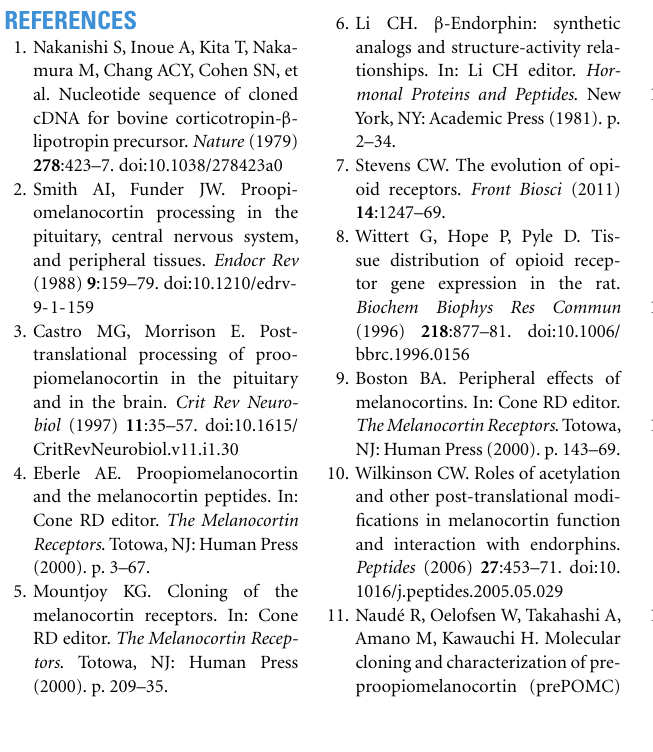
the production of MSH and the opioid peptides β -END and Met- ENK. This functional differentiation may have been established in the evolutionary antecedent of lampreys. α -MSH and β -END are frequently acetylated, and the presence or absence of an acetyl group modifies the biological activities in many vertebrate classes. The lack of acetylated peptides in the PI of lamprey and cartilagi- nous fish pituitaries suggests that acetylation is not a commonly occurring modification in vertebrates. However, the presence of an acetylation system in tetrapods and teleosts suggests the estab- lishment of this system in their common ancestor. Acetylation may be associated with the interaction of the receptor molecules to regulate the roles of POMC-derived peptides. In this context, lampreys and cartilaginous fish lacking acetylation systems may have different regulating systems for the peptide generation in the melanotrophs from teleosts and